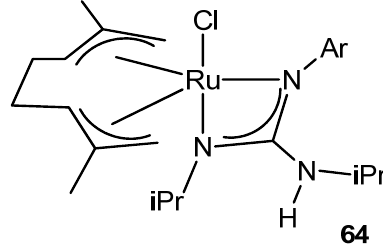
Figure 38. Ruthenium (IV) guanidinato complex [RuCl{ κ 2 -C(NR)(NiPr)NHiPr}( η 3 : η 3 -C 10 H 16 )].